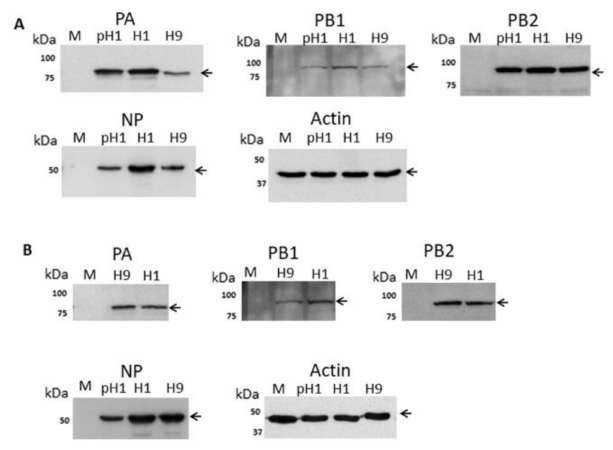
Figure 1. Analysis of the expression of the polymerase proteins in H1N1 / WSN, pH1N1 / 471 and H9N2 influenza virus-infected cells by immunoblotting. ( A ) A549 and ( B ) CEF cells were mock-infected (M) or infected with either H1N1 / WSN(H1), pH1N1 / 471 (pH1) or H9N2(H9) as indicated using a multiplicity of infection (MOI) of 5. At 20 h post-infection (hpi) the cells were harvested, extracted in boiling mix, and immunoblotted with anti-NP, anti-PB1, anti-PB2, anti-PA, and anti-actin (loading control). Protein bands are indicated (black